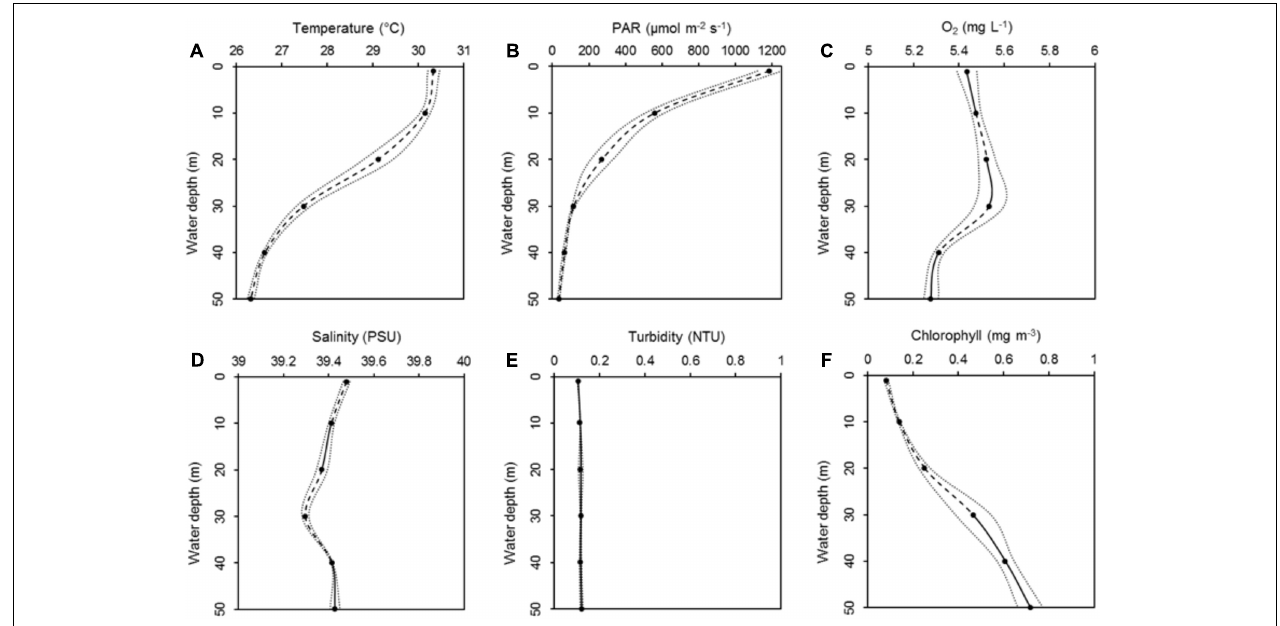
FIGURE 2 | Means of six environmental parameters, i.e., temperature (A) , photosynthetic active radiation (PAR) (B) , dissolved oxygen (O 2 ) (C) , salinity (D) , turbidity (E) , and chlorophyll concentration (F) , along a 50 m water depth gradient measured every 10 m. Data are presented as means ± 95% confidence intervals (dotted lines). Dashed lines represent significant differences between subsequent data points ( p < 0.05). Solid lines represent non-significant differences between subsequent data points. Modified from Ziegler et al. (2015).